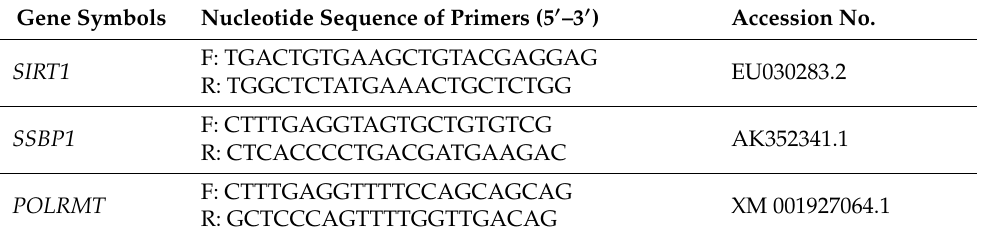
Gene Symbols Nucleotide Sequence of Primers (5 (cid:48) –3 (cid:48) ) Accession